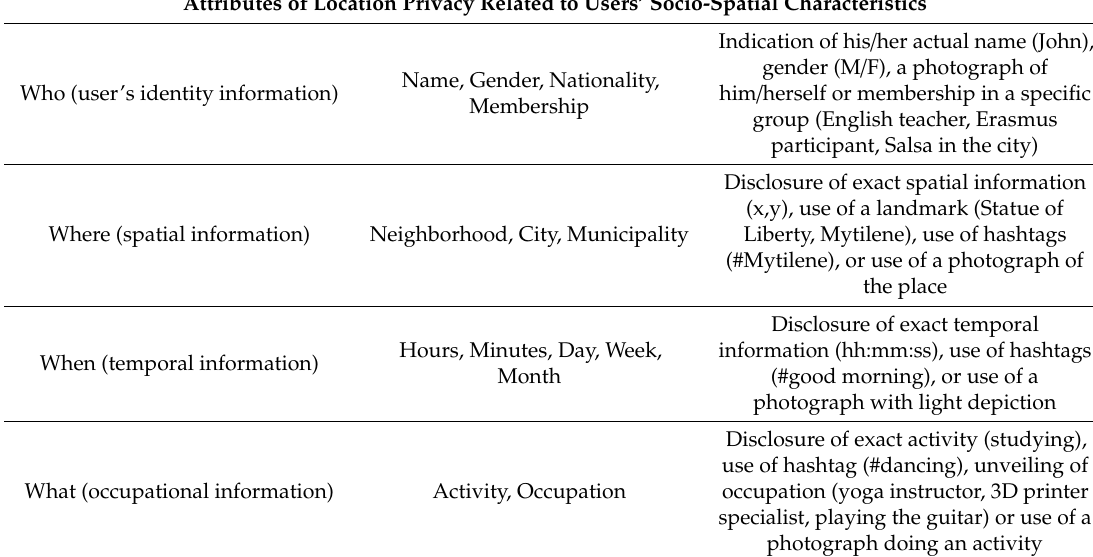
Table 8. Attributes of Location Privacy Related to Users’ Socio-Spatial